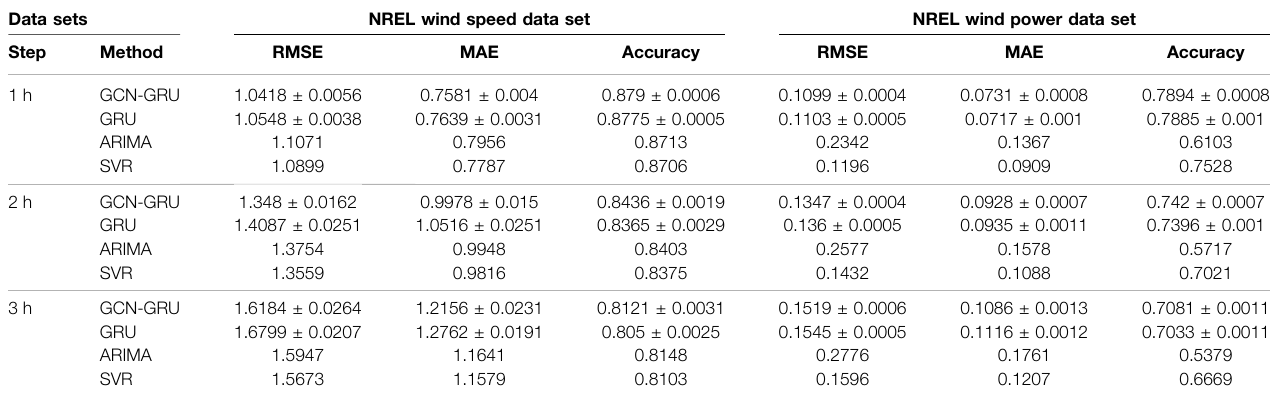
TABLE 5 | The average value of prediction results of all wind stations in NREL wind